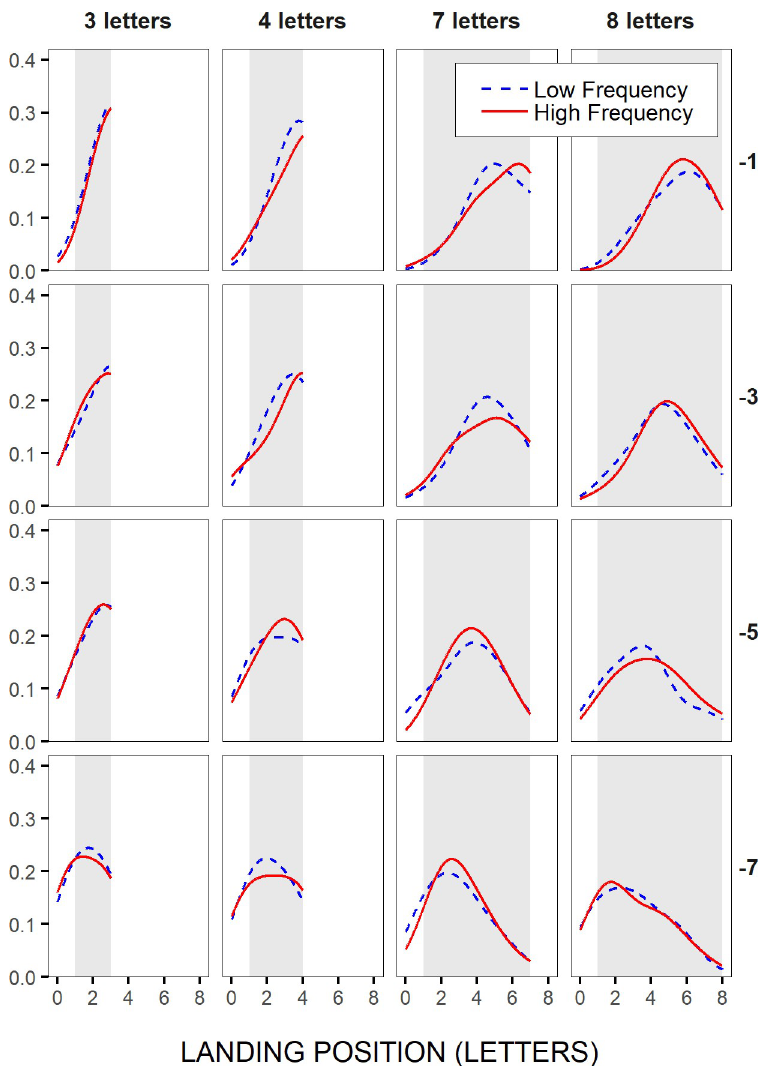
Fig 9. Within-word landing-position distributions. Across-participants probability density functions (bandwidth: 1 letter or 0.25˚; Gaussian Kernel) of initial landing positions in short and long words (3–4 letters and 7–8 letters in left and right panels respectively), and for different saccadic launch-site distances binned in one-letter intervals (from upper to lower panels: -1,-3,-5, and -7 letters respectively relative to the space in front of the words), separately for the two most extreme categories of word frequencies grouped into four bins (see Materials and Methods). Light-grey rectangle areas represent the horizontal extent of the words.